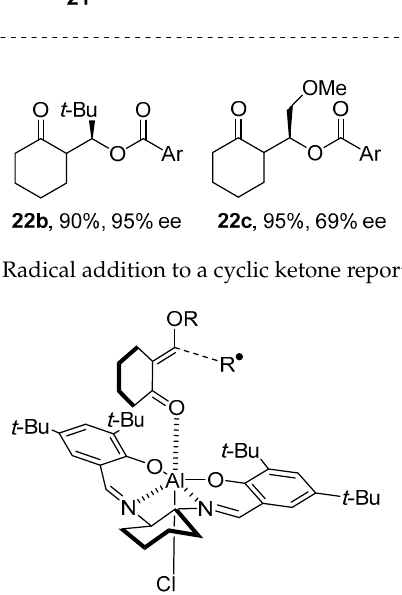
Figure 7. Proposed transition state in the addition of radicals to coordinating ketones.